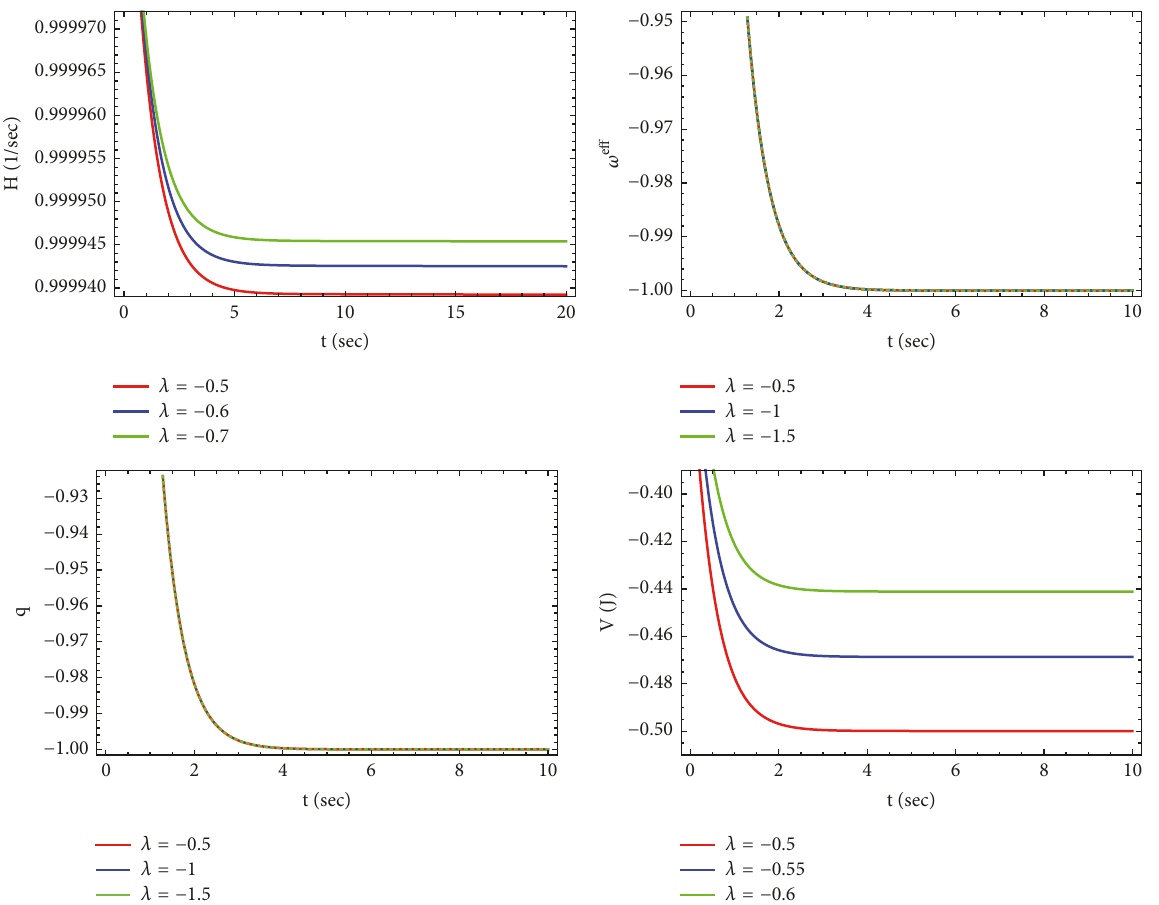
− , 𝑏 1 = 0.0001(1/𝑠𝑒𝑐) , and 𝜑 − (0) = 0.1 when 𝑘 = 1